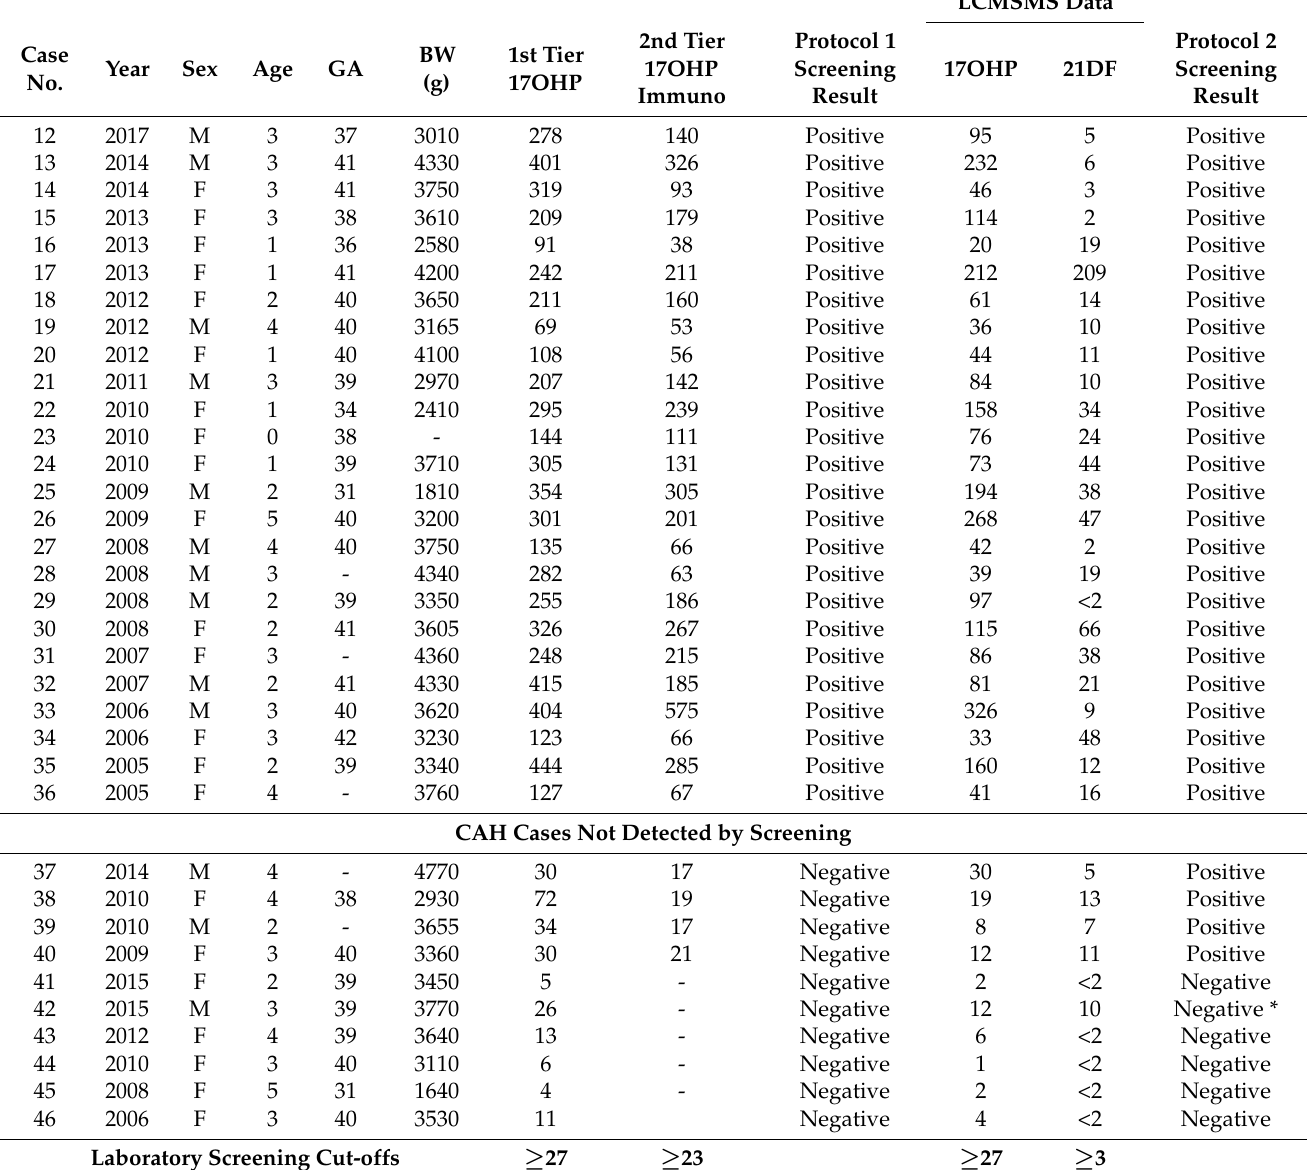
Table 2. NBS data from 35 retrospective specimens from confirmed CAH cases in New Zealand 2005–2017. All 17OHP and 21DF concentrations are nmol/L whole blood. For the purposes of the study, a positive screen was second-tier 17OHP or 21DF above laboratory